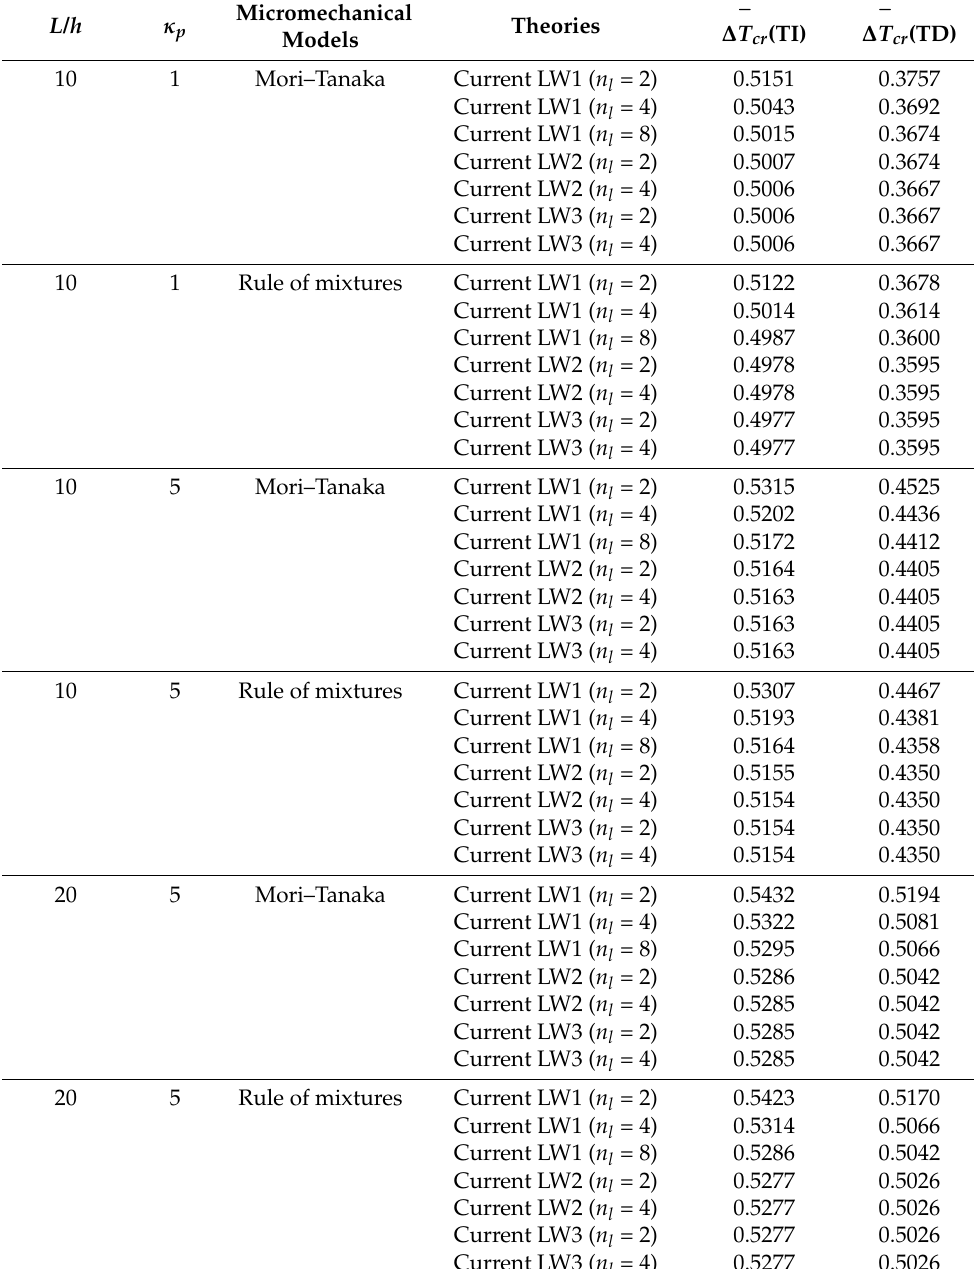
Table 3. Critical temperature parameter solutions for simply supported, FG beams under a uniform temperature